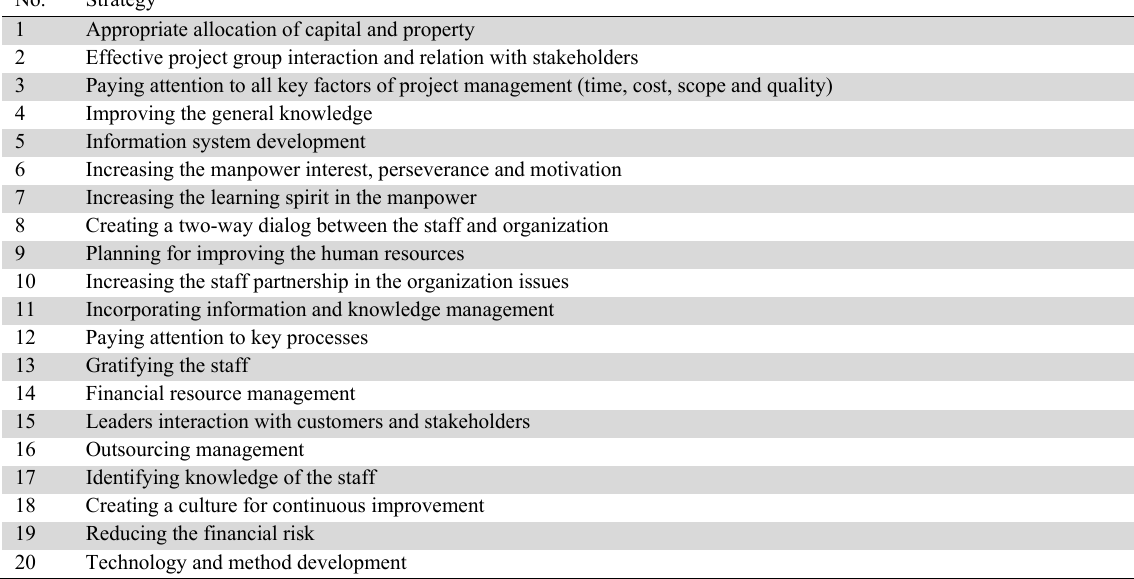
Strategies of the organization (DR)